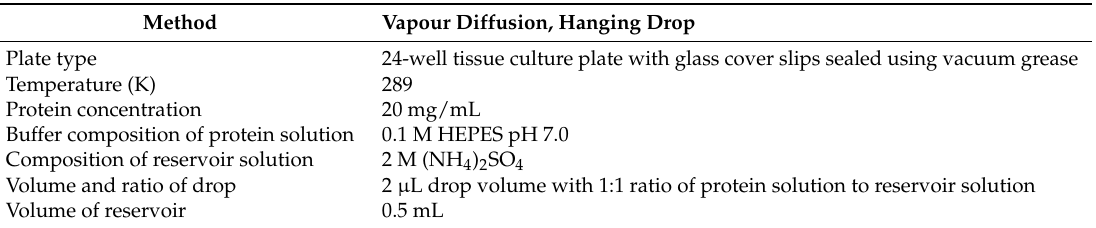
Table 2. Crystallization.